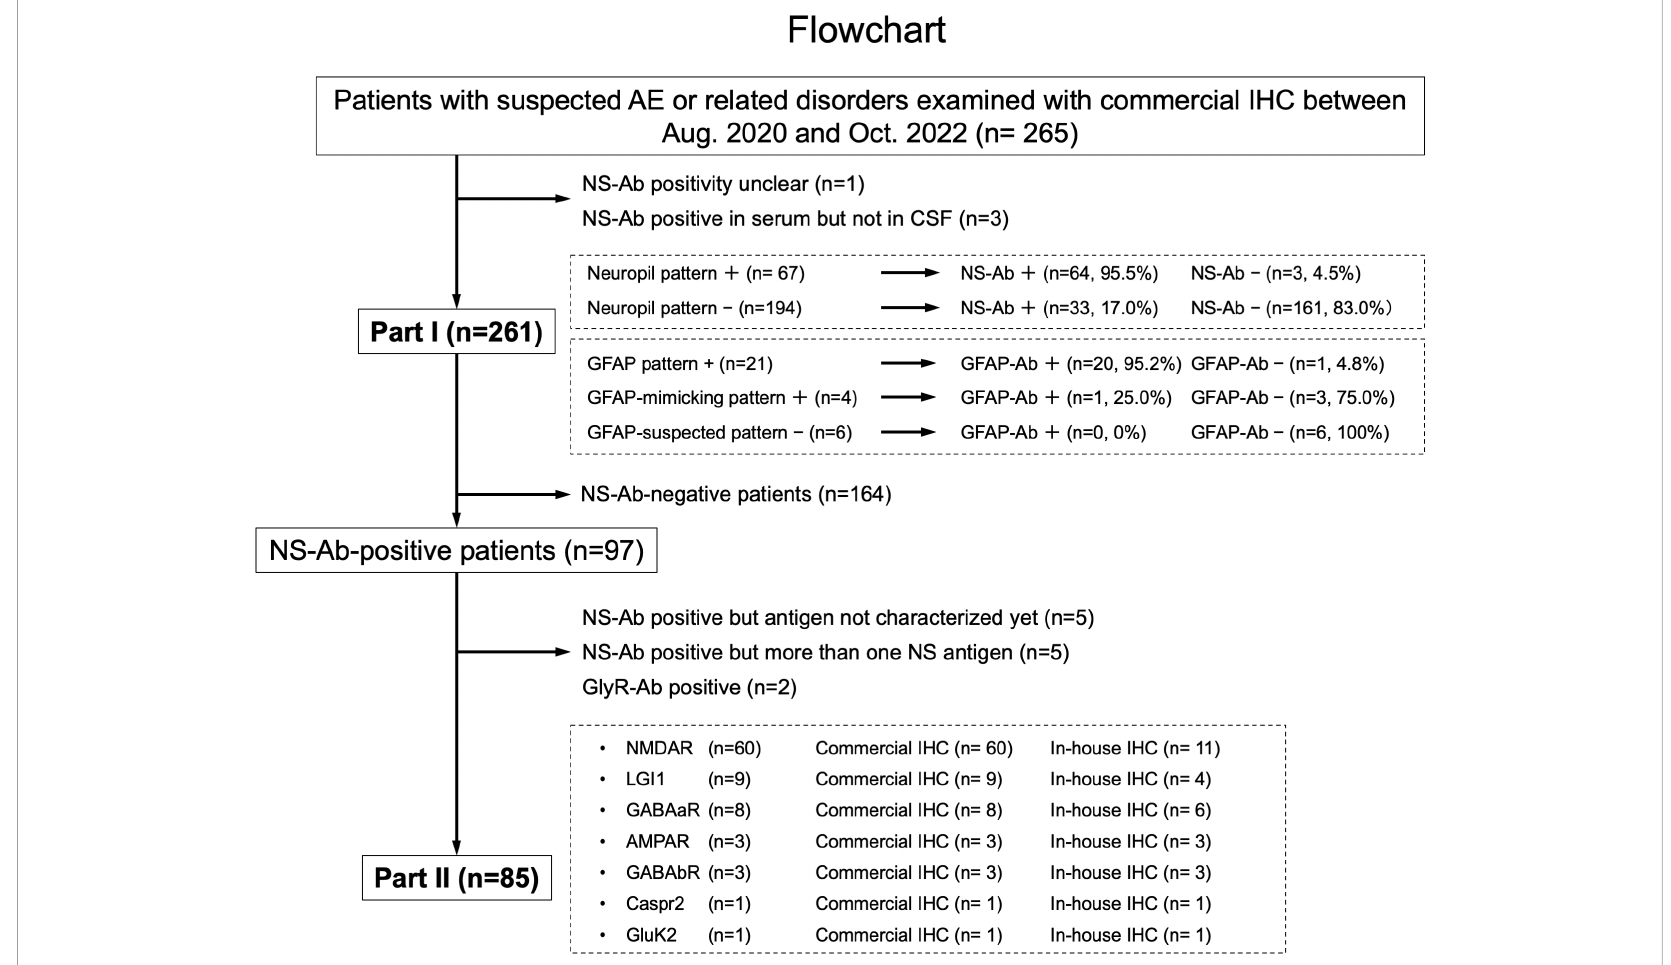
FIGURE 1 This fi gure shows a diagram of the study conducted including Part I and Part II. In Part I, a predictive value of a “ neuropil pattern ” suggesting NS-Ab and a pattern suggesting GFAP-Ab were mainly investigated, whereas in Part II, an immunostaining pattern of the pre-selected 7 NS antigens are evaluated based on the subjects listed here. The number of patients is shown in parentheses. AE, autoimmune encephalitis; Ab, antibodies; GFAP, glial fi brillary acidic protein; IHC, immunohistochemistry; NS, neuronal